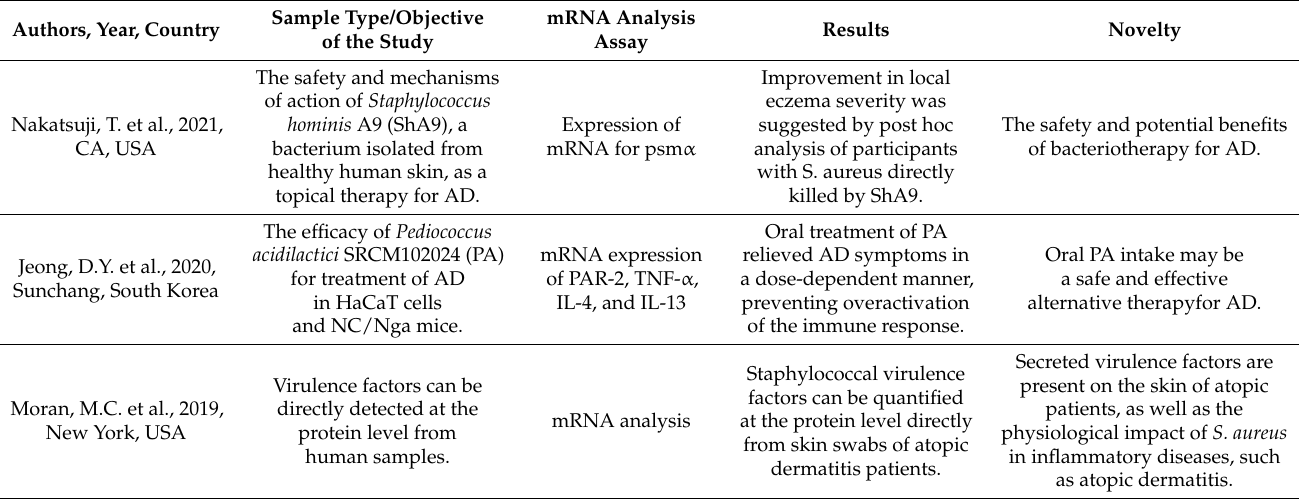
Table 1. Associations between AD and bacterial mRNA